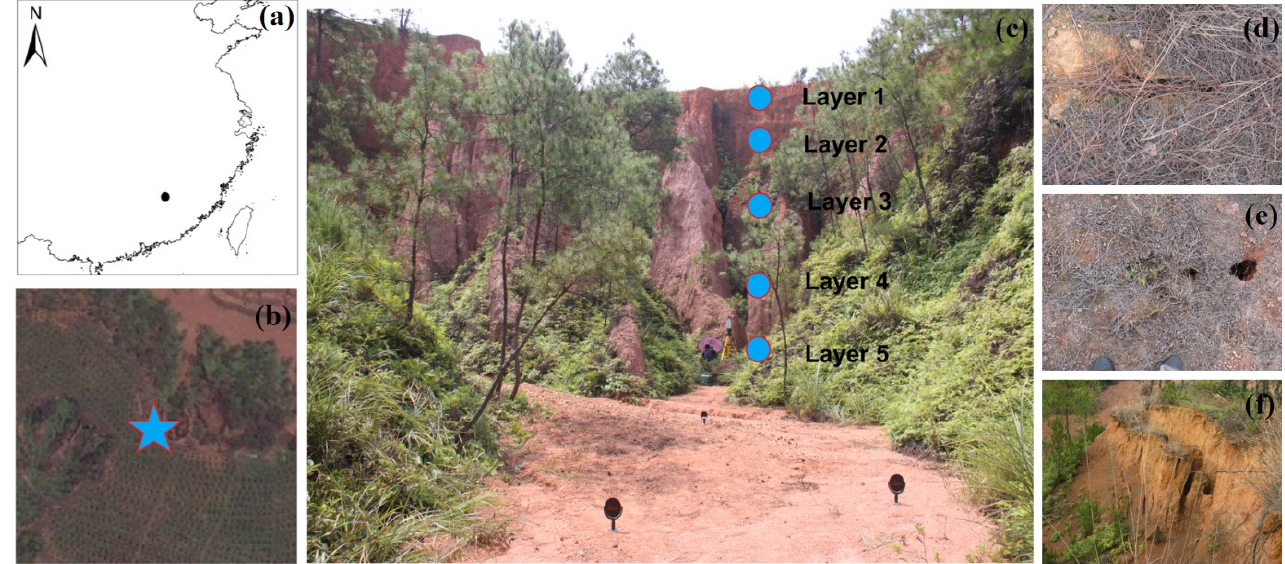
Figure 1. The location of Zuoma small catchment ( a ), the sampled gully ( b ), sampling points ( c ), and exhibition of crack ( d ), pipe ( e ), and slide ( f ) along the gully wall in Yudu county, Jiangxi province.